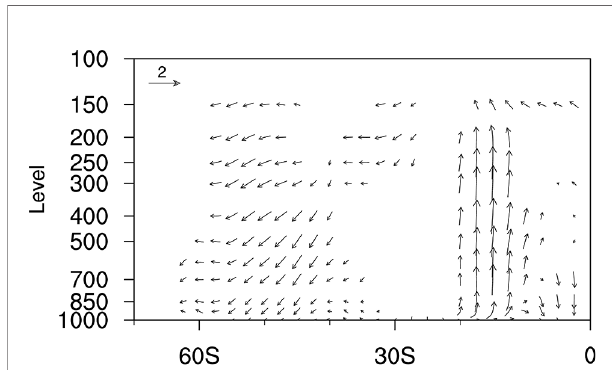
FIGURE 9 | Regression coef fi cients of zonal mean vertical wind anomalies (vectors: m/s) of 90°-120°E on the normalized NDJF-averaged SOI. Only anomalies signi fi cant at the 95% signi fi cance level are shown.